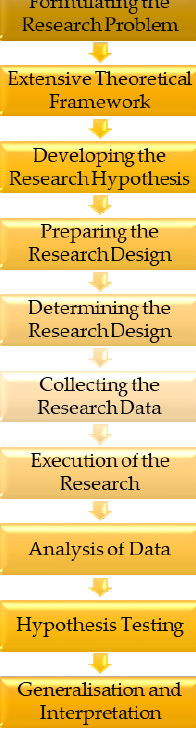
Figure 1. Research design of the studied theme. Source: Author ’ s own.